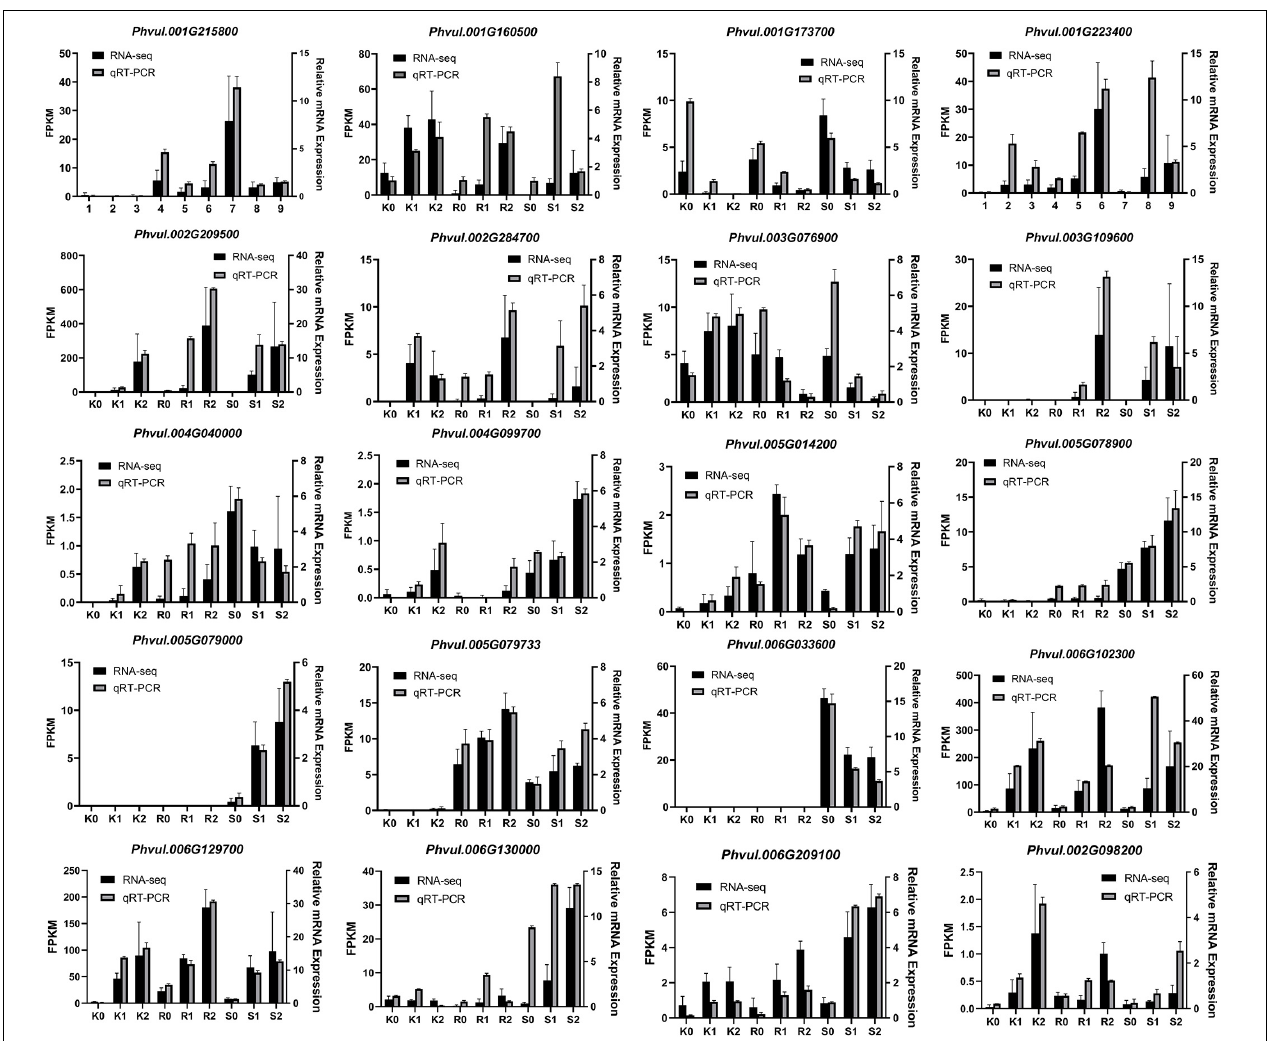
FIGURE 5 | Comparison of genes expression levels using RNA-seq and qRT-PCR. K, tepary bean PI 319443; R, resistant genotype HR45; S, susceptible genotype Bilu. 0, 1 and 2 represent 0, 24 and 48 h post inoculation,